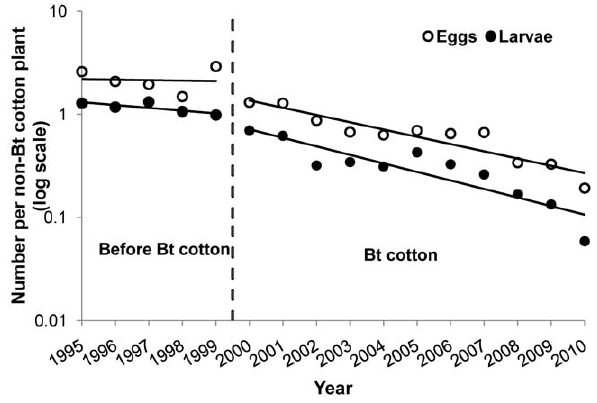
Figure 3. Pink bollworm abundance on non-Bt cotton before and after adoption of Bt cotton. Before Bt cotton (1995–1999), annual average abundance did not change significantly for eggs (slope= 2 0.0048, df=3, R 2 =0.004, P =0.92) and larvae (slope= 2 0.027, df=3, R 2 =0.64, P =0.10). With Bt cotton (2000–2010), annual average abundance declined significantly for both eggs (slope= 2 0.070, df=9, R 2 =0.86, P , 0.0001) and larvae (slope= 2 0.083, df=9, R 2 =0.80, P